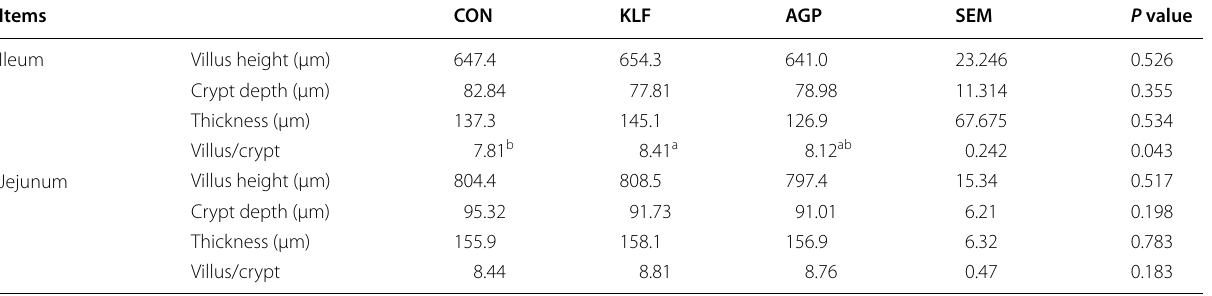
CON the control treatment; AGP the Aureomycin supplementation treatment; KLF Kudzu-leaf flavonoids a,b means within a row, different letters differed significantly ( P <